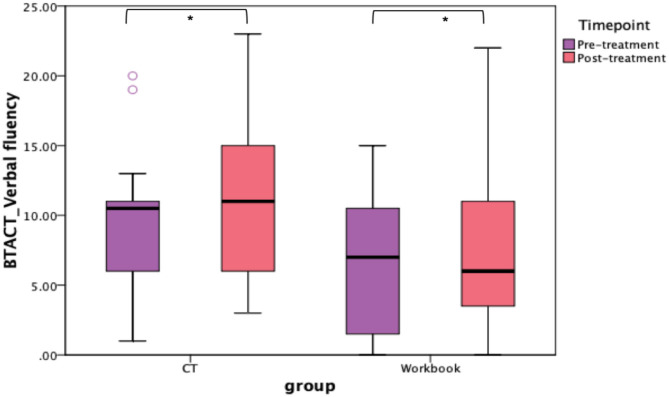
Unadjusted means for BTACT for the two groups (CT-R and workbook) pre-treatment and post-treatment. Significant differences are marked with *. *p < 0.05.